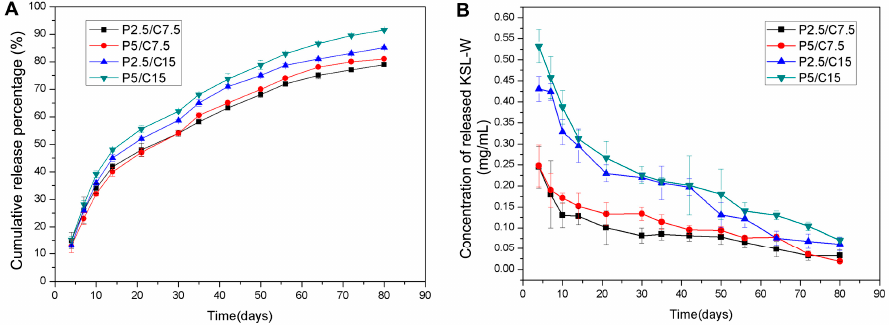
Figure 3. In vitro release profile of KSL-W from PLGA/CS microspheres. ( A ) Cumulative release percentage of KSL-W; ( B ) The concentration of released KSL-W. (Data are shown as the means ± standard deviation, n = 3).